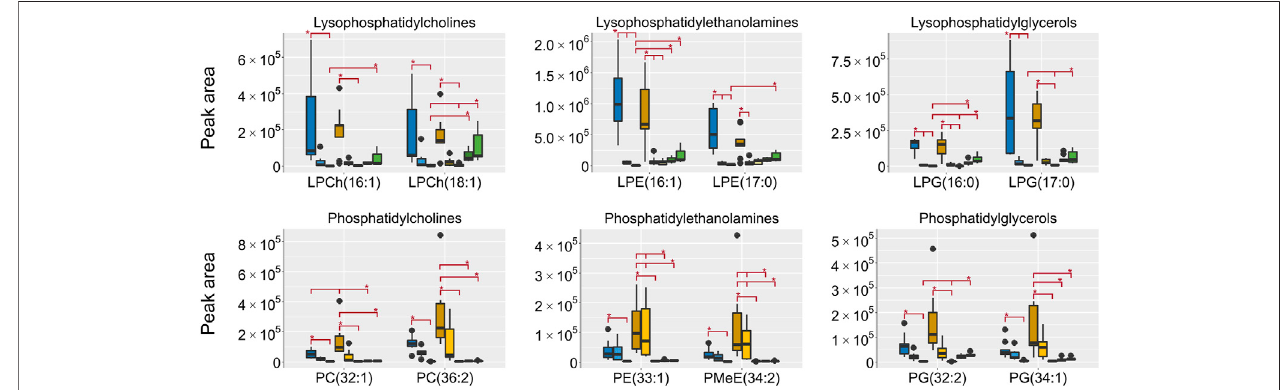
FIGURE 10 | Box plots of peak areas ( y -axis) of lipids found as differentiating between the sample groups in the organic extracts, the data was collected in RP negative ionization. Presented here are examples from each of the lipid classes, all annotated lipids can be found in the supplementary data. EtOH extr.1 (dark blue ), EtOHextr.2(blue ),EtOHsp.(lightblue ),MeOHextr.1(darkorange ),MeOHextr.2(yellow ),MeOHsp.(lightyellow ),frozen(darkgreen ),and fl ashfrozen (green ). Outliers aredenoted as dots in theplots. Statistical signi fi cance ( p < 0.05) ismarked by* in the respective box-plots, all p -values from the Kruskal Wallis and Nemenyi post-hoc testing can be found in supplementary data, Supplementary Table S13